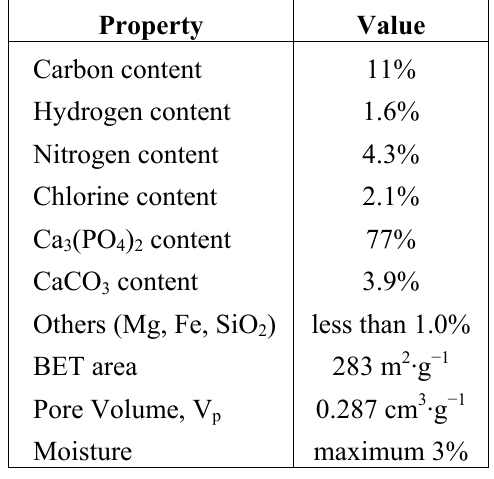
Table 1. CBC physical and chemical